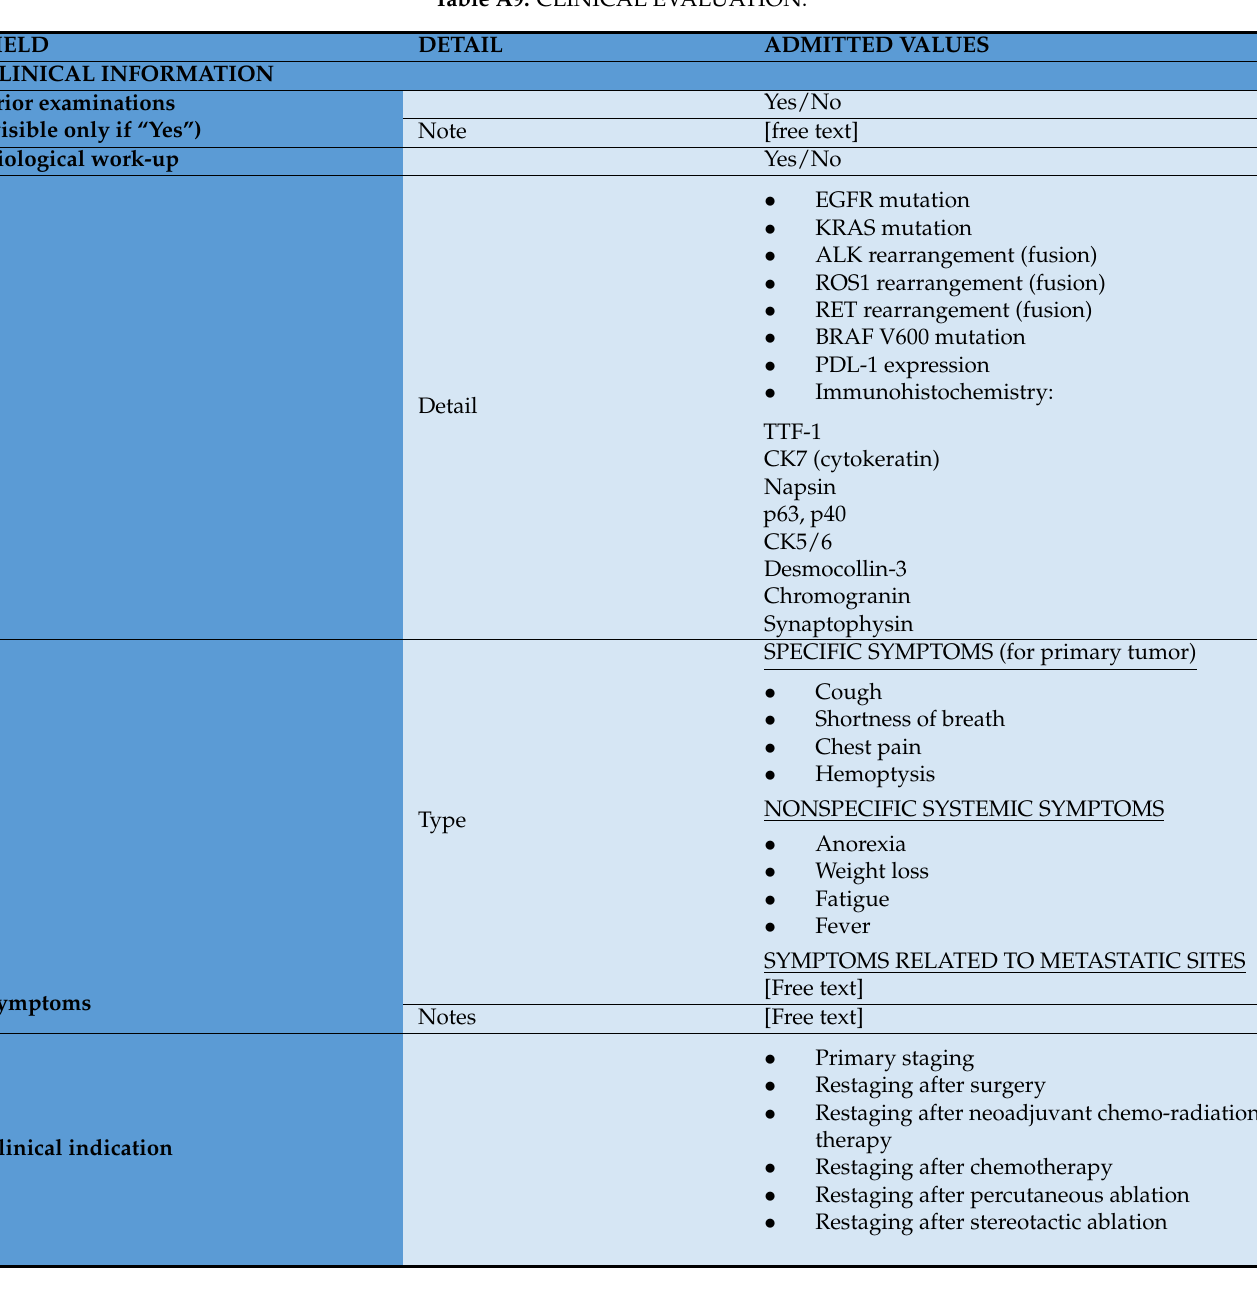
Table A9. CLINICAL EVALUATION.